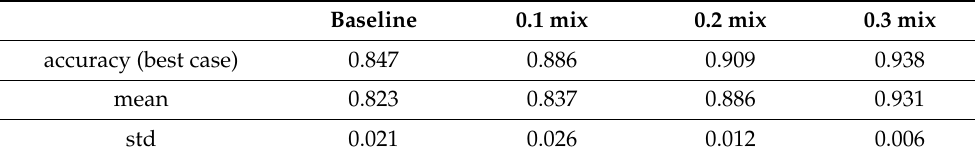
Table 3. Accuracy values obtained with different balancing of a dataset.